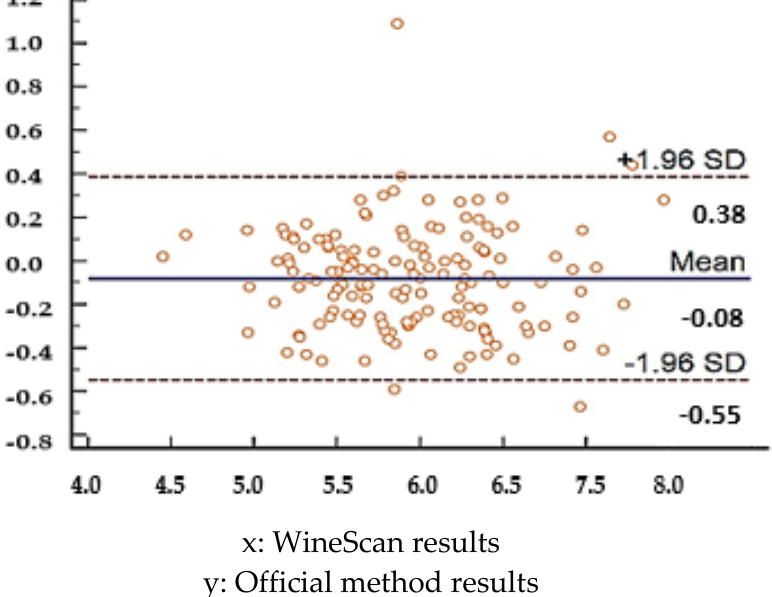
Figure 12. Bland–Altman Test of total acid results obtained by the official method and WineScan technology. The dashed line represents the regression confidence. The continuous line represents the interval limits.